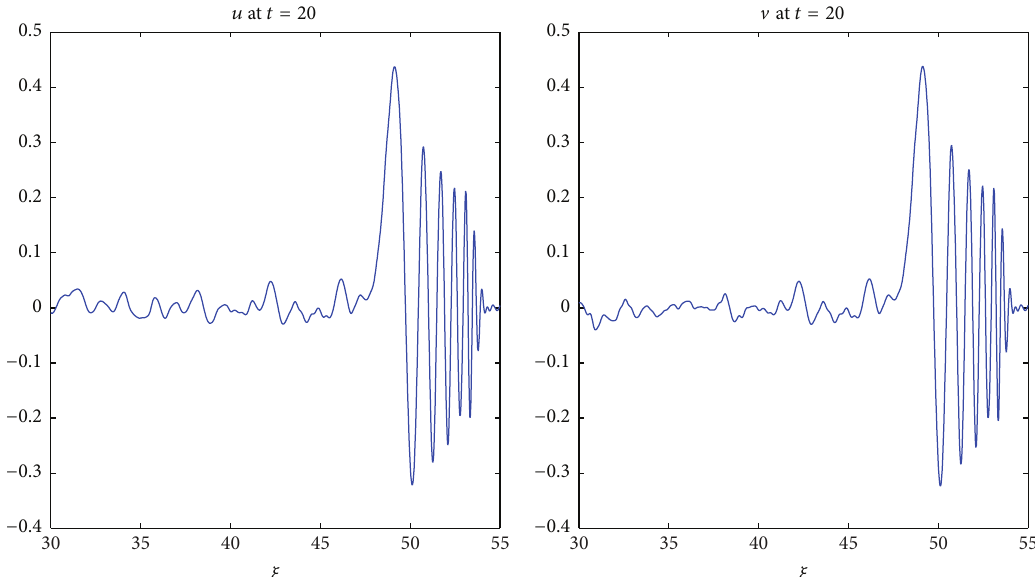
Figure 15: Evolution of a Gaussian pulse over a channel with the variable depth shown in Figure 14 and taking into account surface tension effect. Parameters: 𝛼 = 0 , 𝛽 = 0.01 , and 𝜎 = 0.6 .